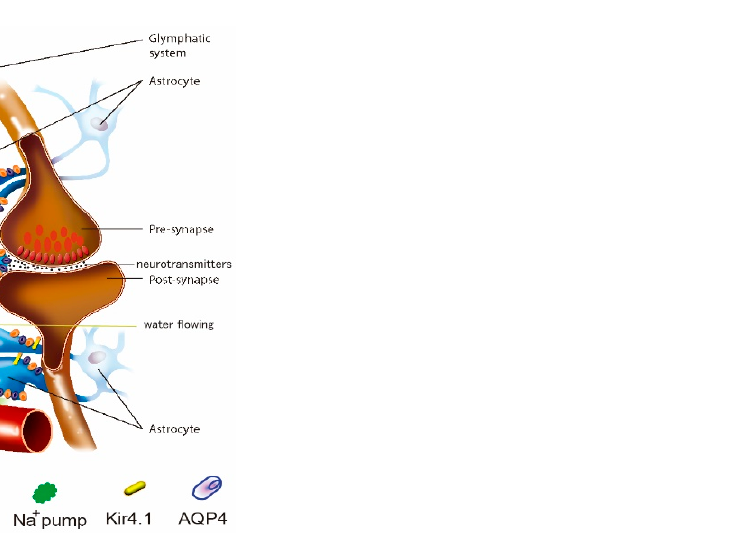
Figure 1. Schematic drawing showing the structure of the glymphatic system, which is composed of the perivascular space (PVS) and astrocytic end feet. The fluid passes from interstitial fluid to cerebrospinal fluid (CSF) in the PVS around the small blood vessels in the brain, which is important for the clearance of ROS and cytokines, etc. The glymphatic system can actively transport the fluid through ion channels, such as AQP4 (purple dots), K + channels (such as NKCC1; orange dots), and co-transporters (such as Glt1; yellow dots).